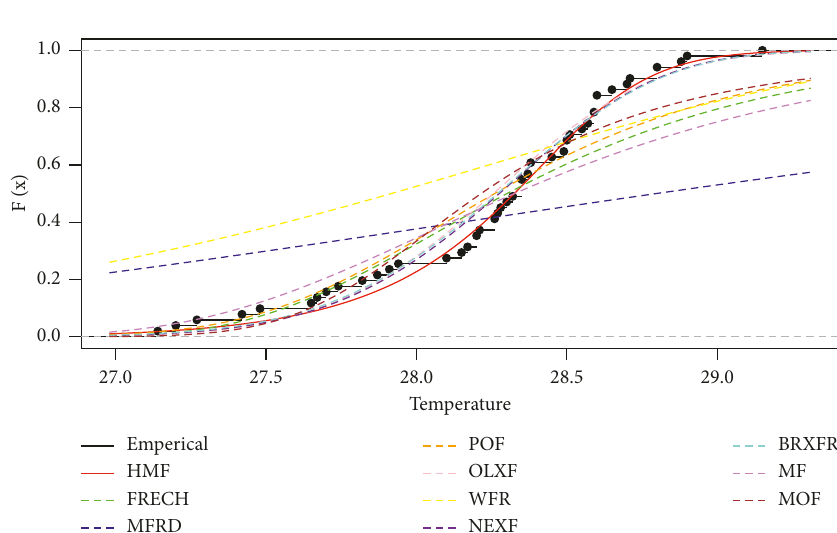
Figure 3: Fitted PDFs for annual maximum temperature dataset.